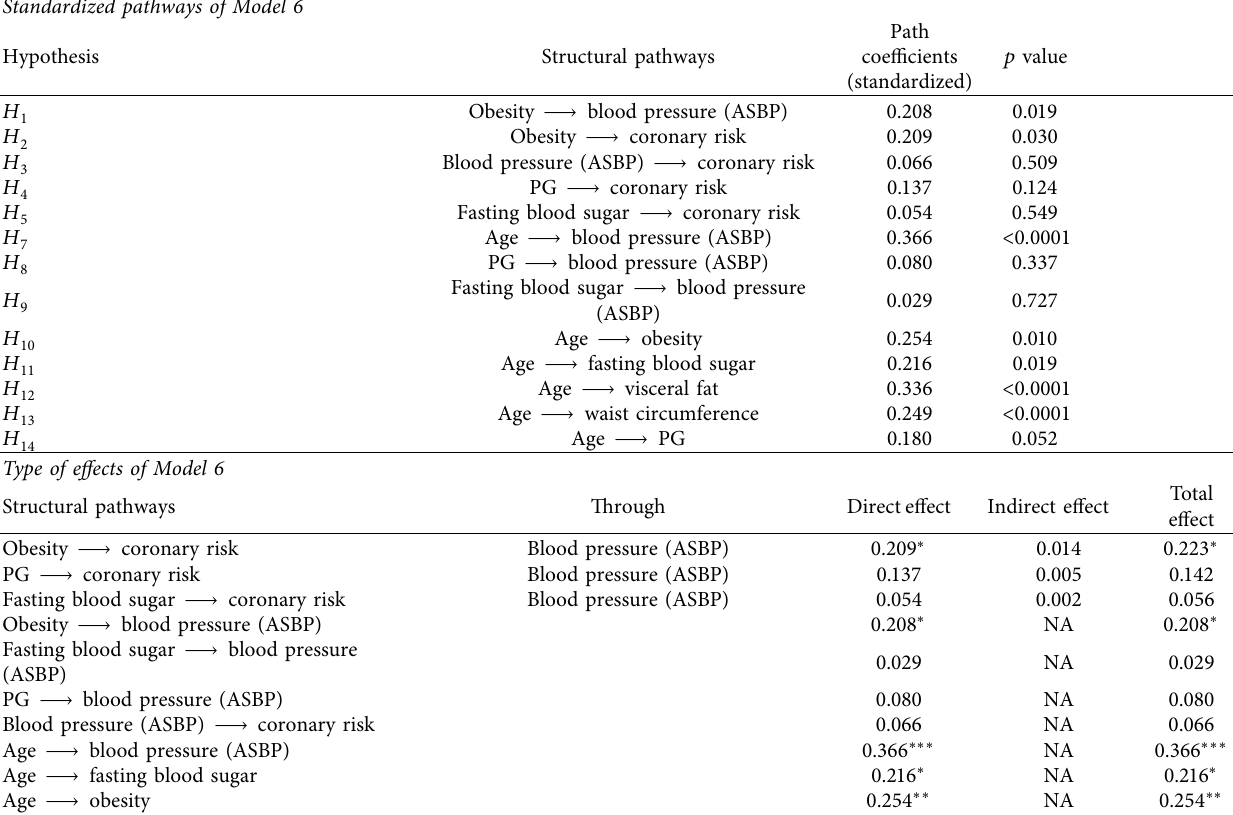
Table 9: Standardized pathways and type of effects of Model